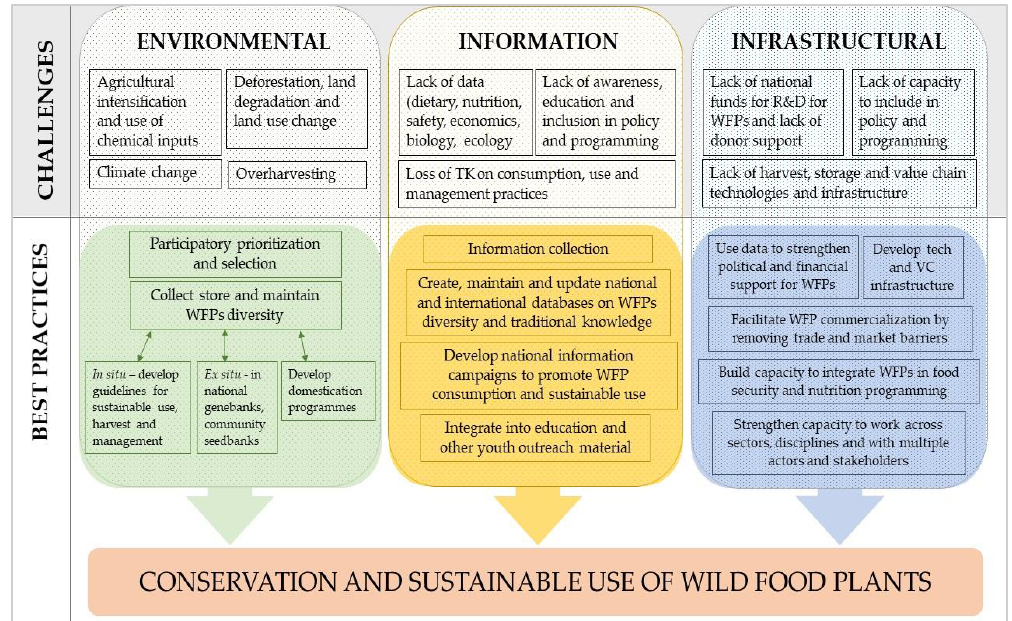
Figure 2. Proposed best practices for the long-term co-creation of conservation and sustainable use of WFPs help overcome many of the challenges